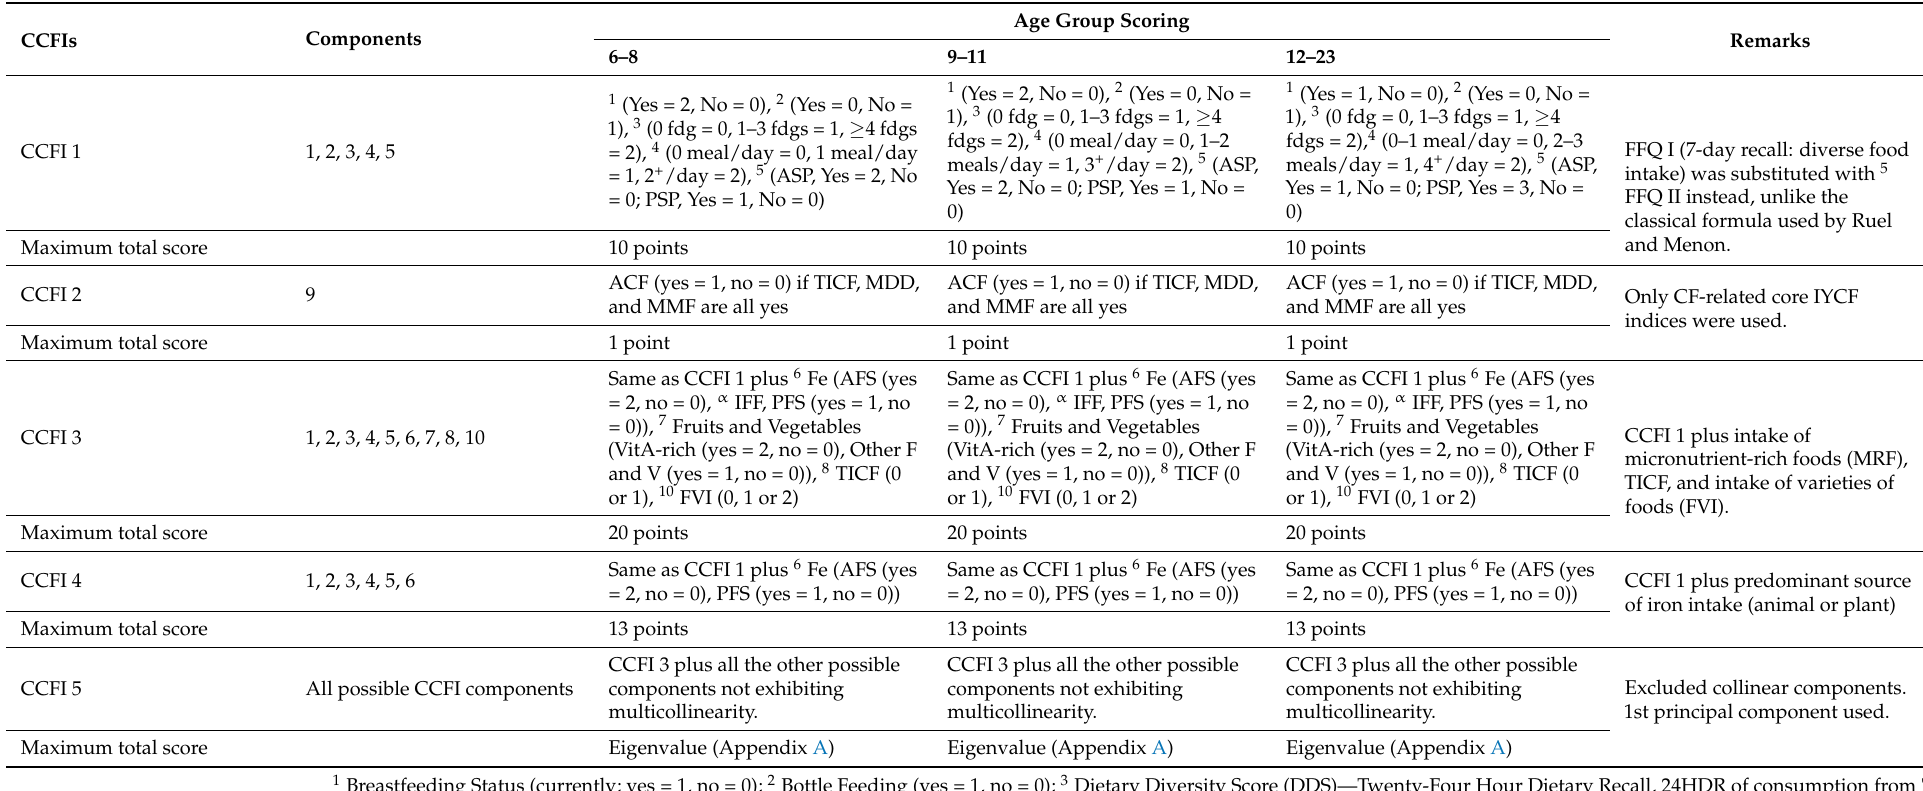
Table 2. Formulas (components and criteria) applied for CCFI construction and